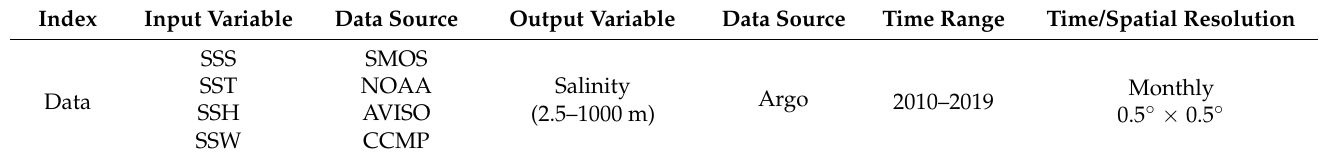
Table 1. Summary of the data used in this